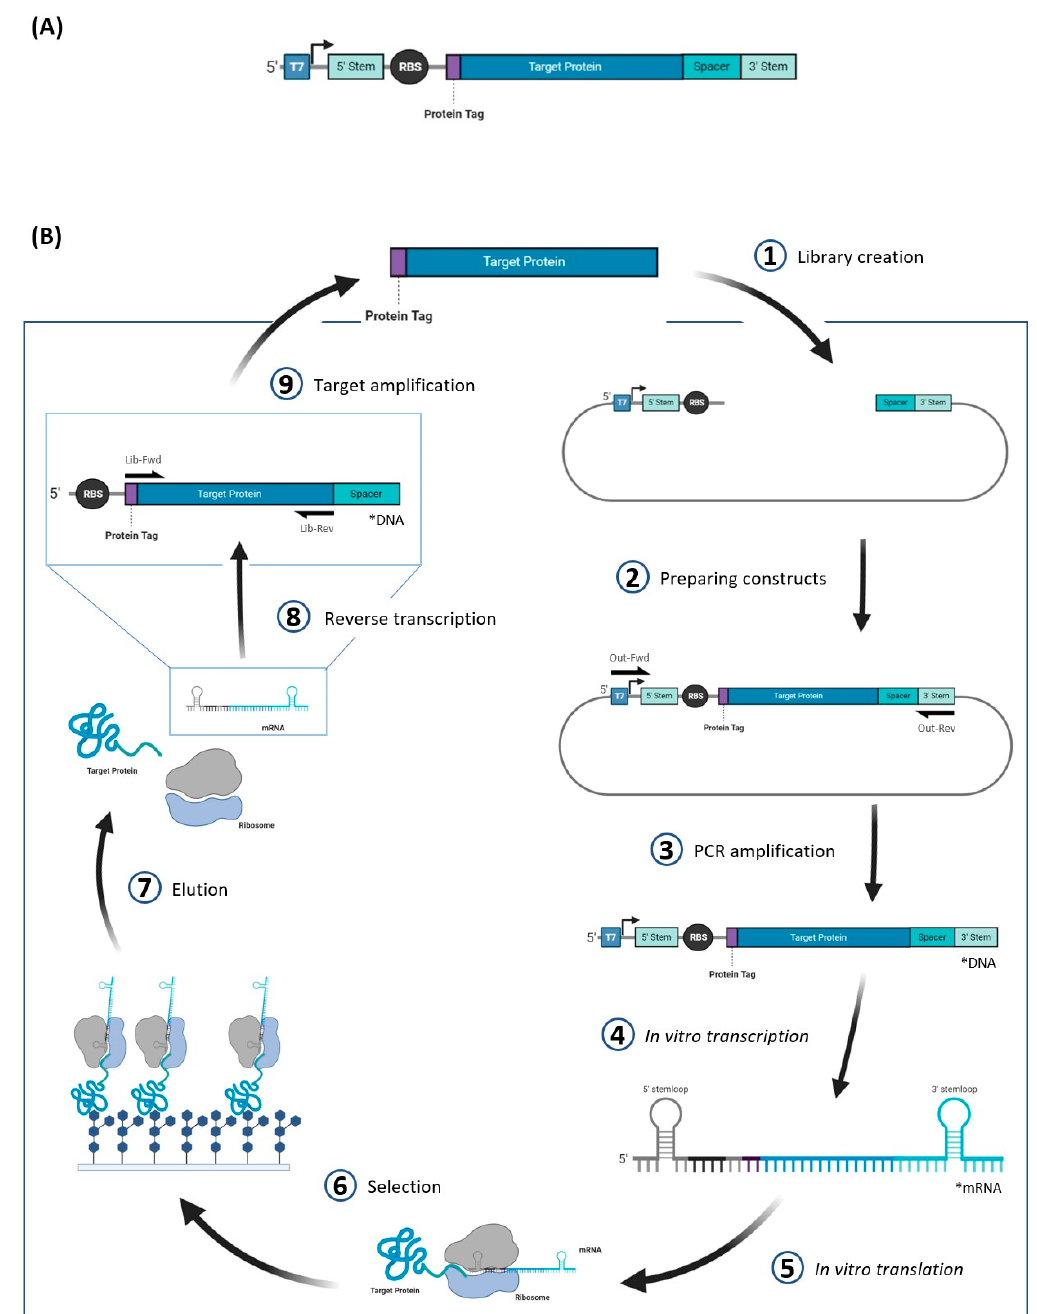
Figure 4. Overview of the ribosome display method. ( A ) Construct design for ribosome display. The sequence that is transcribed (4) during the ribosome display contains 5 ′ and 3 ′ stem loop regions that help prevent degradation of the subsequent mRNA. ( B ) Cyclic representation of ribosome display. The plasmid used for ribosome display typically includes the promoter, stem loop regions, RBS, and spacer region.